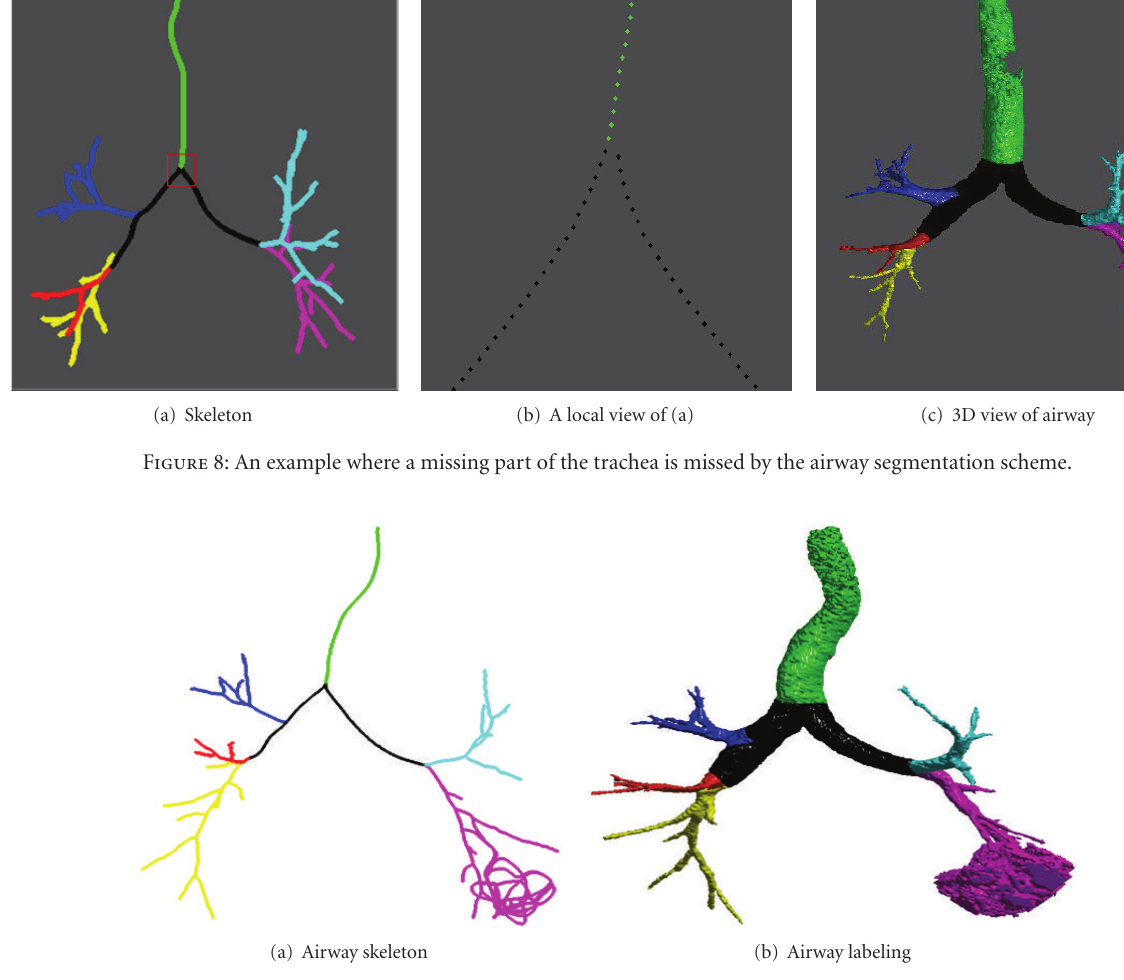
Figure 9: An example with airway